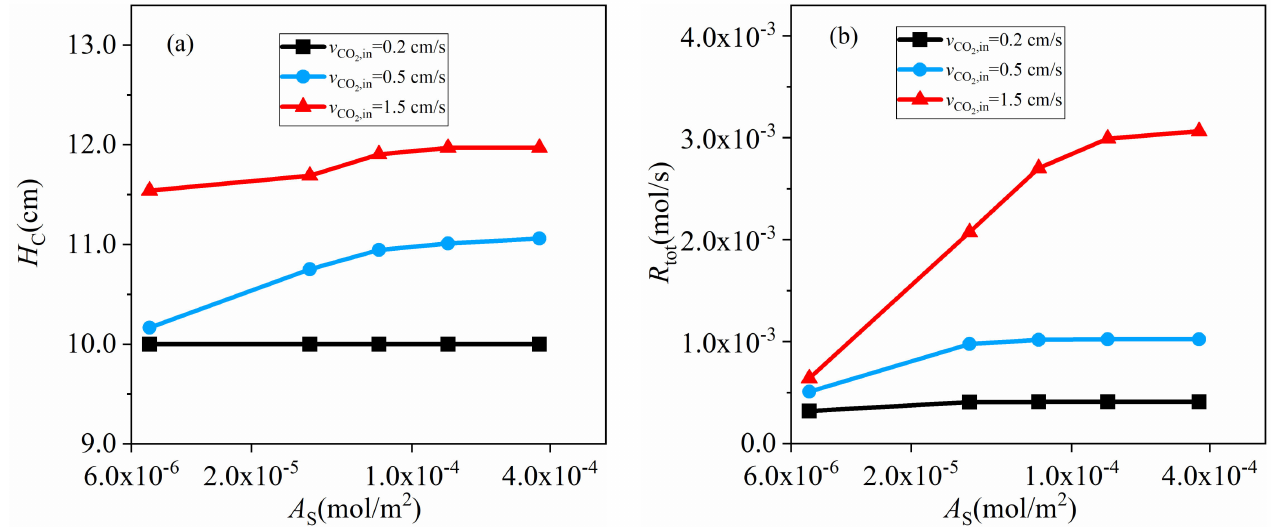
Figure 5. Effect of active site densities A s and inlet velocity v CO rate, R tot